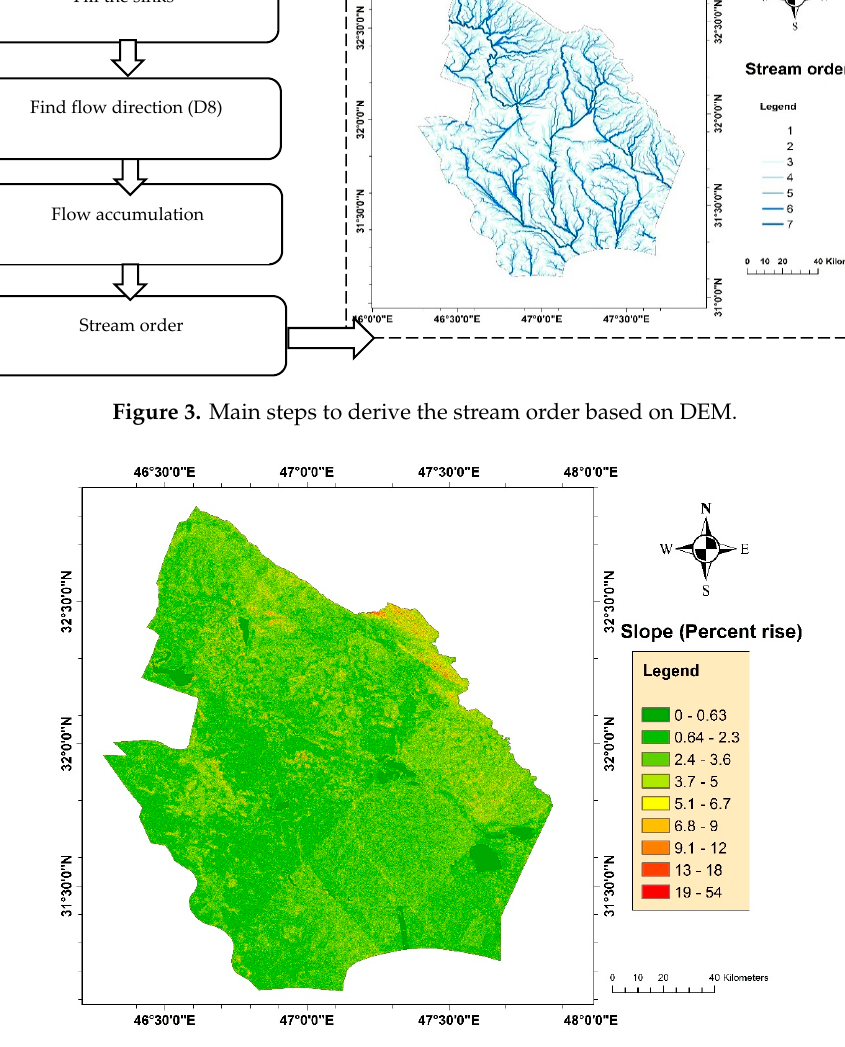
Figure 4. Slope percent rise map .